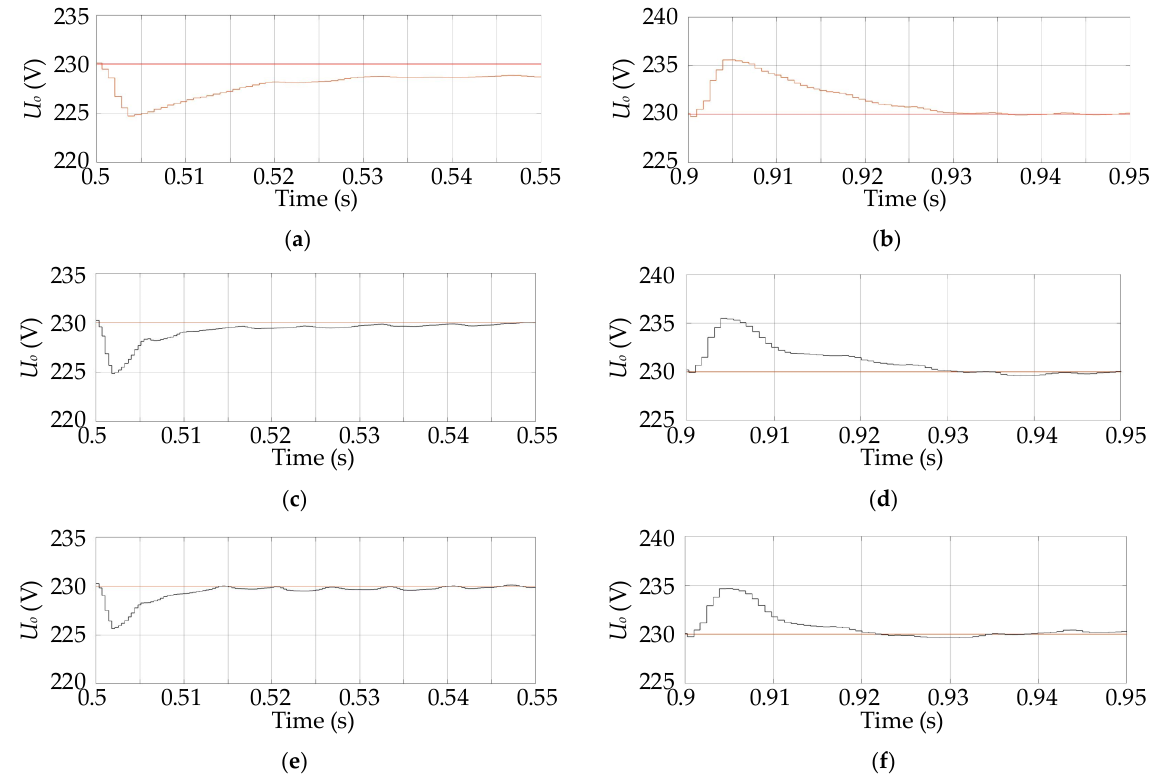
Figure 14. Dynamic performance of a power generation system at 6795 r/min: ( a ) suddenly loaded with a PI controller; ( b ) suddenly unloaded with a PI controller; ( c ) suddenly loaded with a fuzzy PI controller; ( d ) suddenly unloaded with a fuzzy PI controller; ( e ) suddenly loaded with a dual fuzzy PI controller; ( f ) suddenly unloaded with a dual fuzzy PI controller.